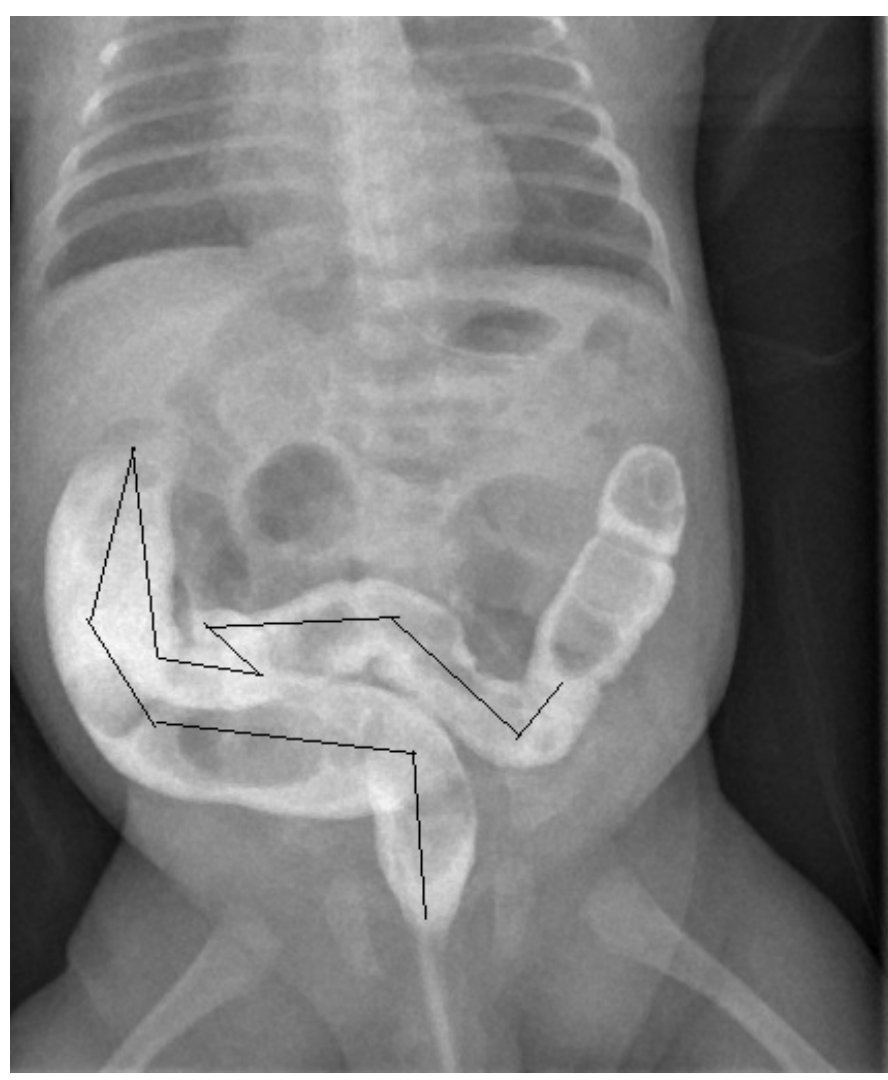
Figure 1. Image of CE of 2-months-old infant: the black line shows the rectosigmoid